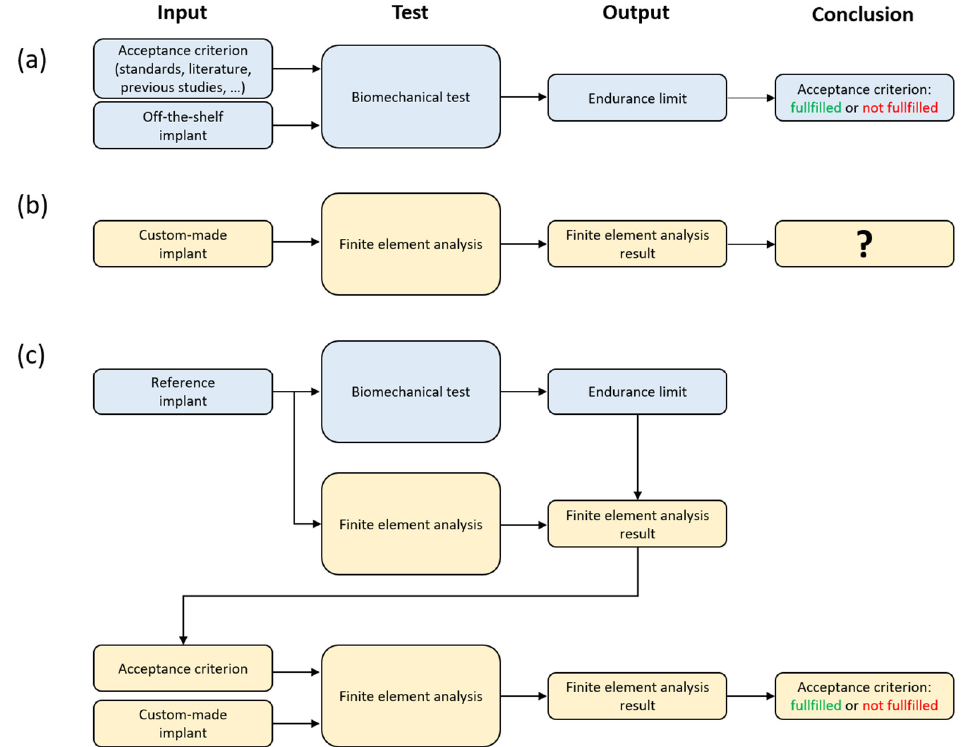
Figure 1. Pre-clinical biomechanical testing. ( a ) Biomechanical test of an off-the-shelf implant with a pre-defined acceptance criterion leads to certain conclusion. ( b ) A finite element analysis (FEA) of a custom-made implant does not yield to a conclusion since the acceptance criterion for the FEA cannot be defined in advance. ( c ) An FEA of the custom-made implant yields to a conclusion when using the outputs of the biomechanical test and of the FEA of the reference implant as the acceptance criterion for the custom-made